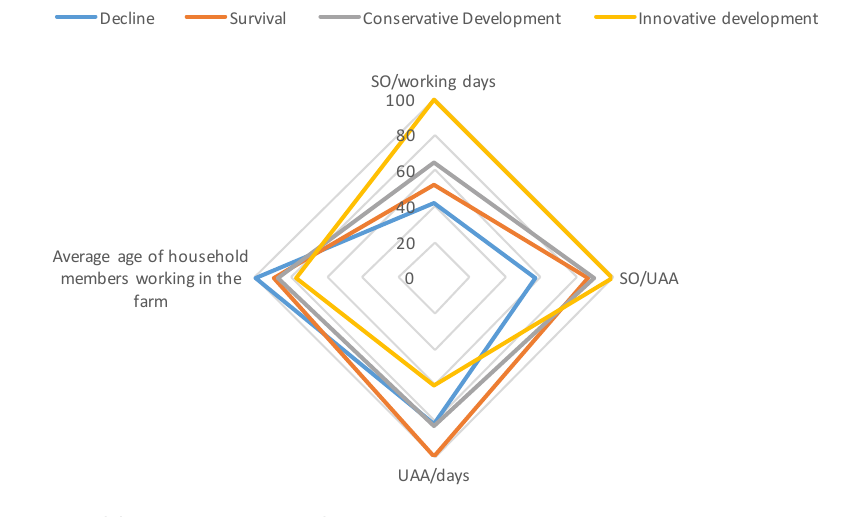
Figure 5. Mugello - Land and labour productivity indices according to farming styles.